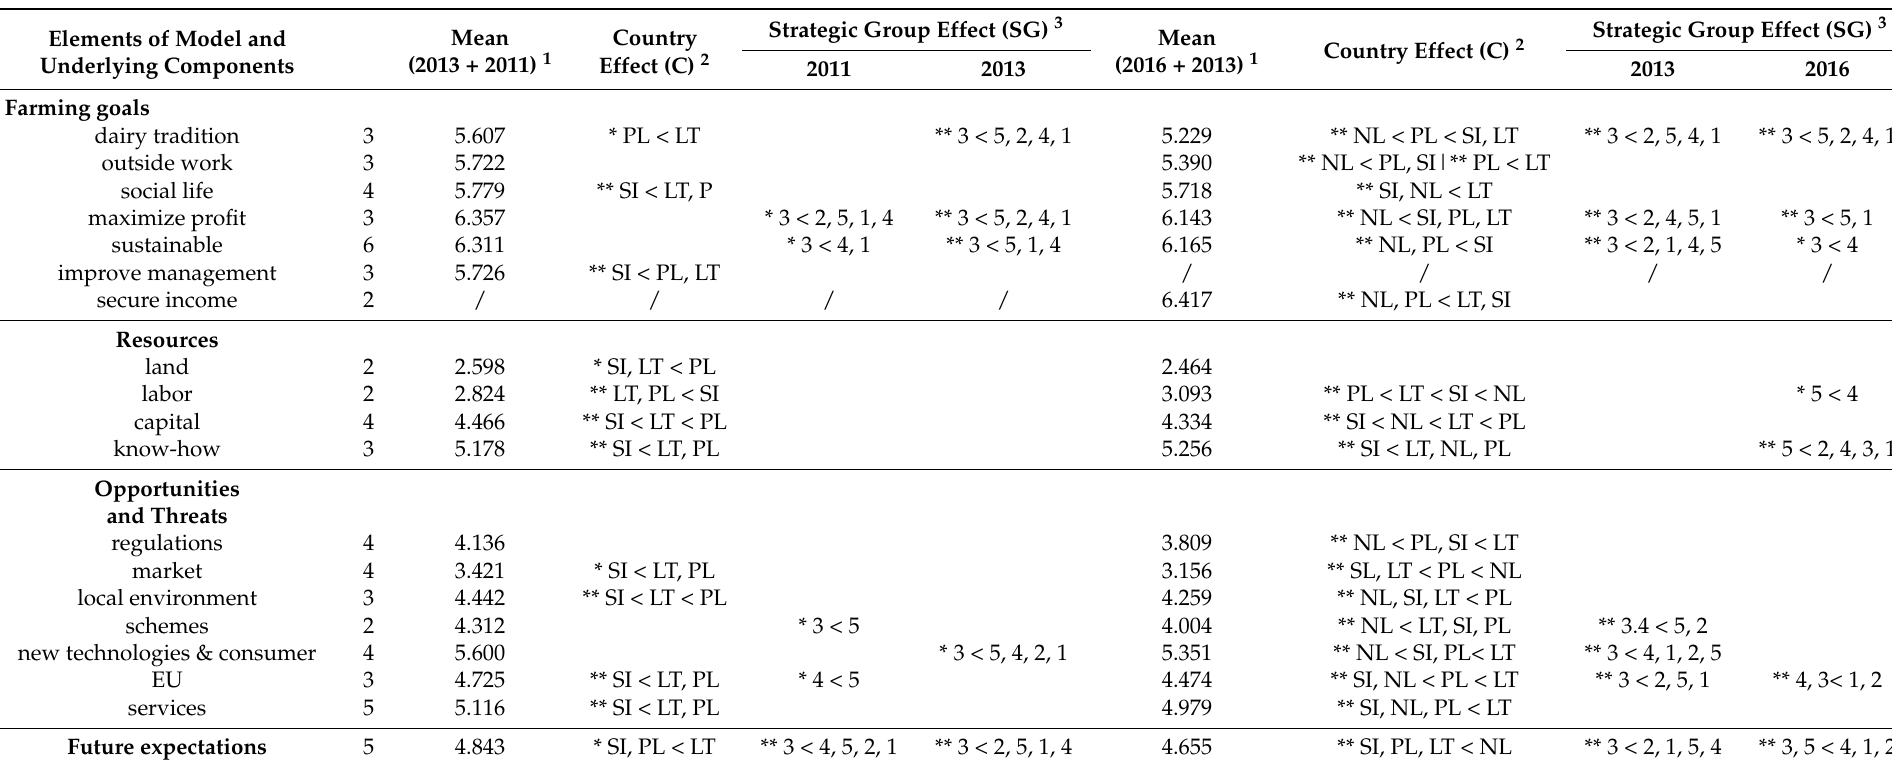
Table 6. Effect of country and strategic group on mean scores in Farming goals, Resources, Opportunities and Threats and Future prospects in periods 2011 to 2013 and 2013 to 2016, analysed by